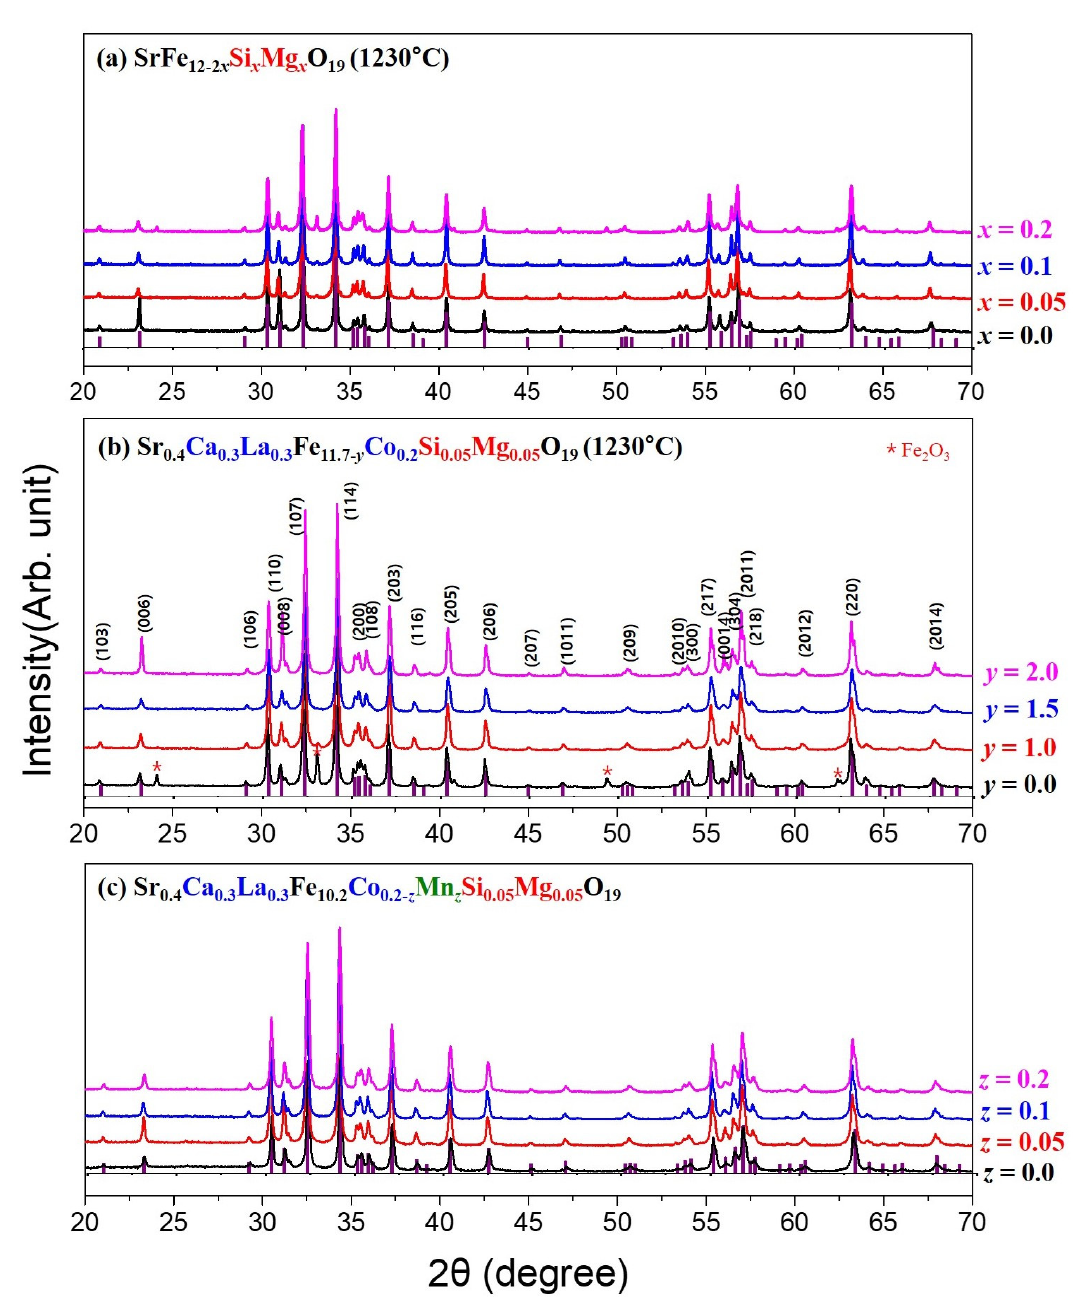
Figure 1. ( a – c ) XRD patterns of SrFe 12 − 2 x Si x Mg x O 19 ( x = 0, 0.05, 0.1, 0.2), Sr 0.4 Ca 0.3 La 0.3 Fe 11.7 − y Co 0.2 Si 0.05 Mg 0.05 O 19 ( y = 0, 1, 1.5, 2), and Sr 0.4 Ca 0.3 La 0.3 Fe 10.2 Co 0.2 − z Mn z Si 0.05 Mg 0.05 O 19 ( z = 0, 0.05, 0.1, 0.2) samples sintered at 1230 °C.